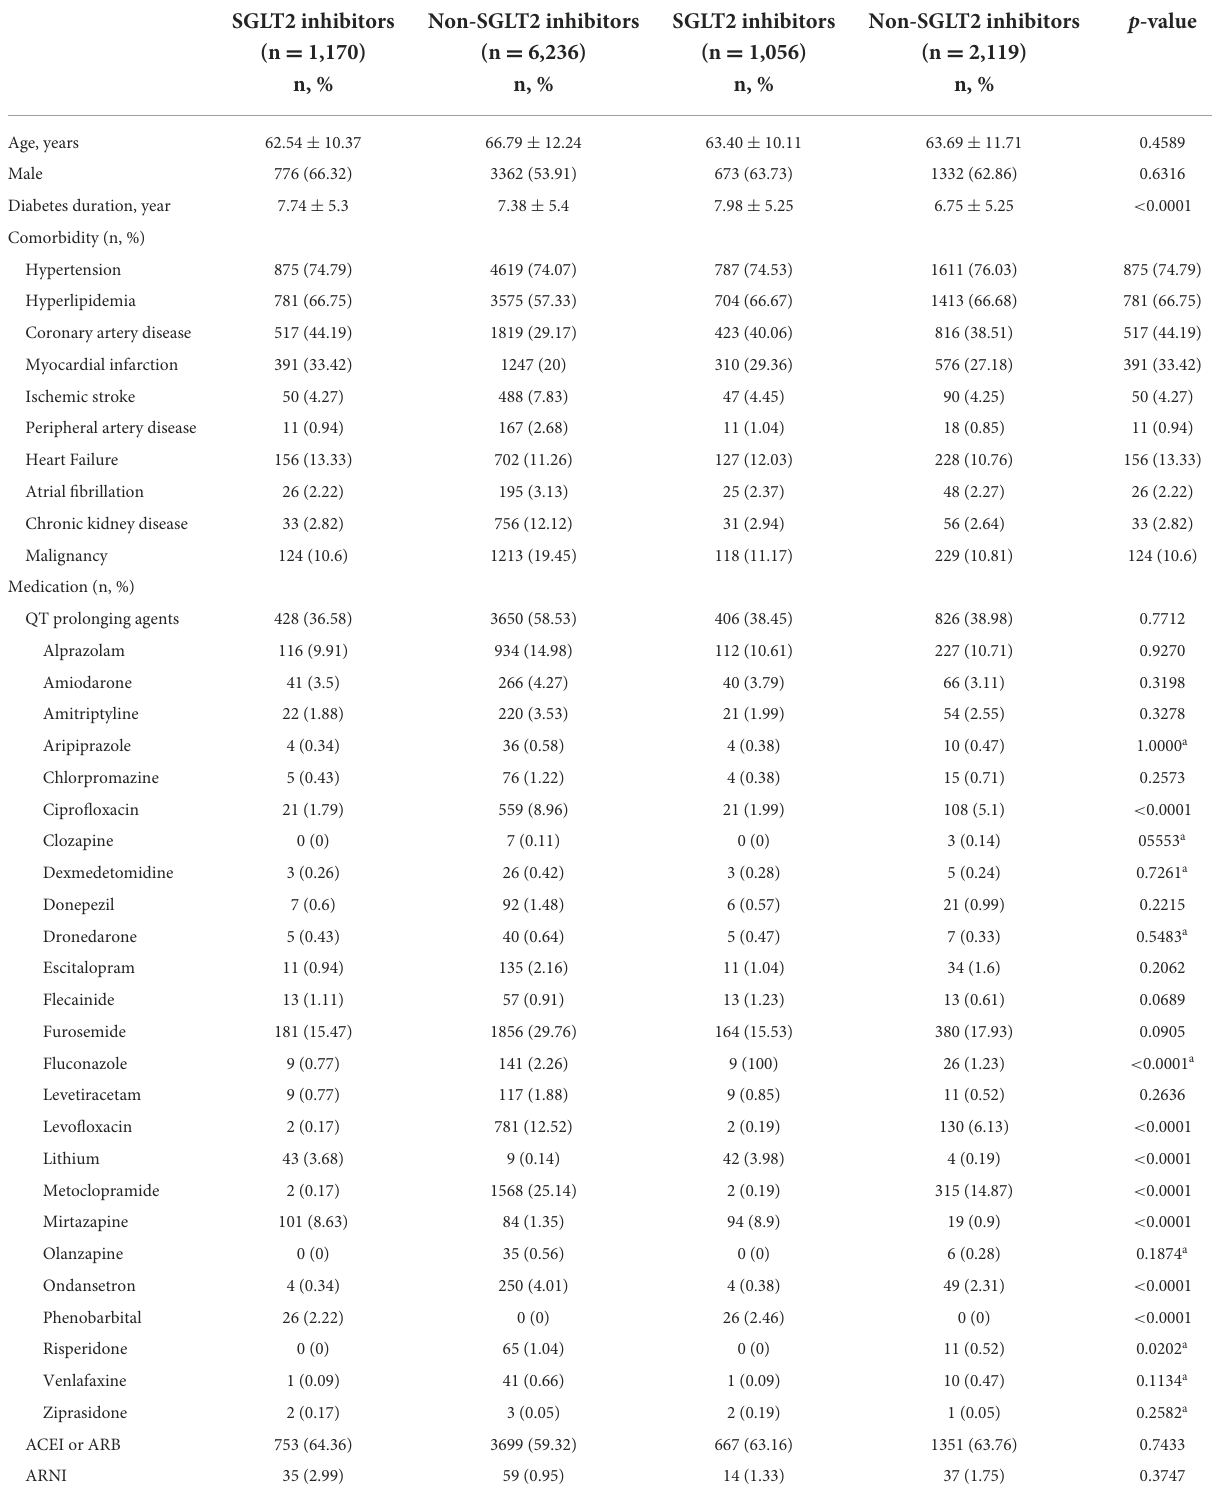
TABLE 1 Clinical characteristics of study